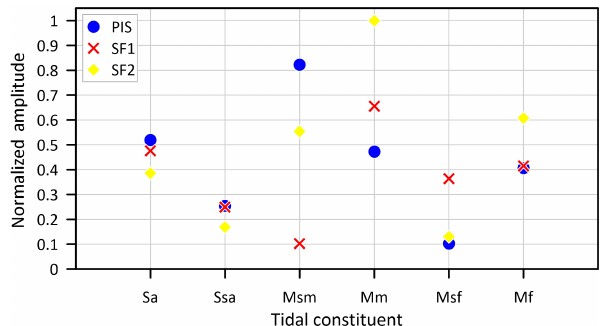
Figure 3. Amplitudes (normalized to the maximum) of the tidal constituents identified in the temperature time-series recorded by the three TIR